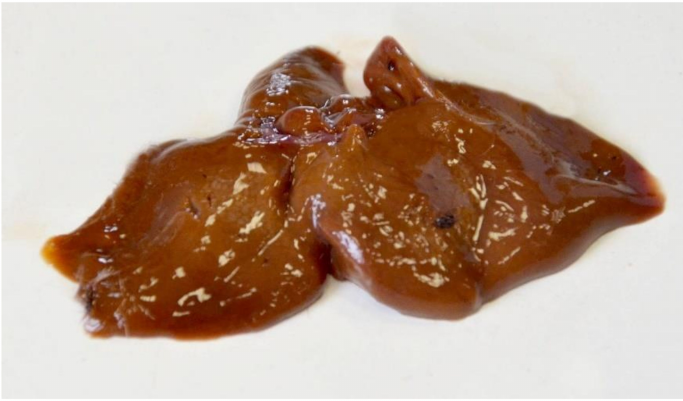
Figure 6. Liver. Appearance of yellowish color.